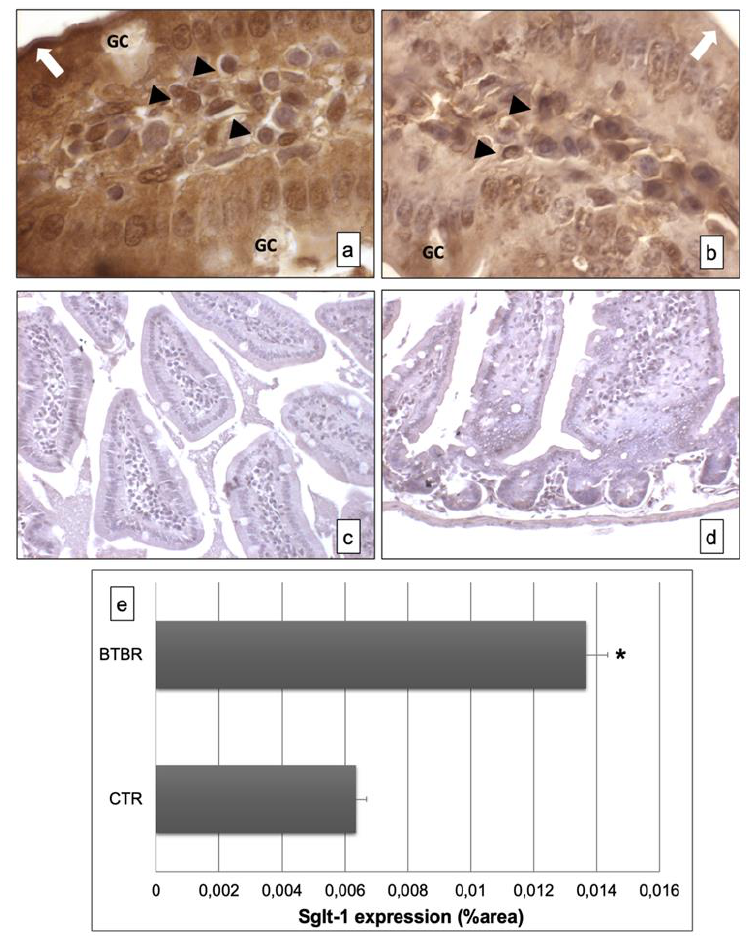
Figure 3. Representative images of Sglt-1 immunostaining in small samples of BTBR and CTR mice (( a , b ) respectively). The immunohistochemical signal (brown) is localized in the intracellular com- partment and apical portion (highlighted by a white arrow) of small intestine and in some lymphatic cells of the submucosa. The negative controls of immunohistochemistry are shown in images ( c , d ) for BTBR and CTR animals respectively. ( e ) Statistical analyses of this immunohistochemical technique for intracellular compartment and apical portion of small intestine. Data are presented as mean ± SD. * p < 0.01 vs. CTR mice. Goblet cells are indicated as GC; lymphatic cells (i.e., plasma cells) are indicated with arrowheads ( a , b ); apical portion of the enterocytes are indicated as white arrows in ( a , b )—1000 × . The number of animals was 10 for BTBR and 10 for CTR; moreover, three samples for each animal were used. The images are a representative sample of all the tissues exam- ined.